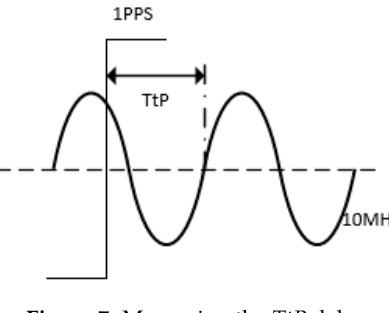
Figure 7. Measuring the TtP delay.